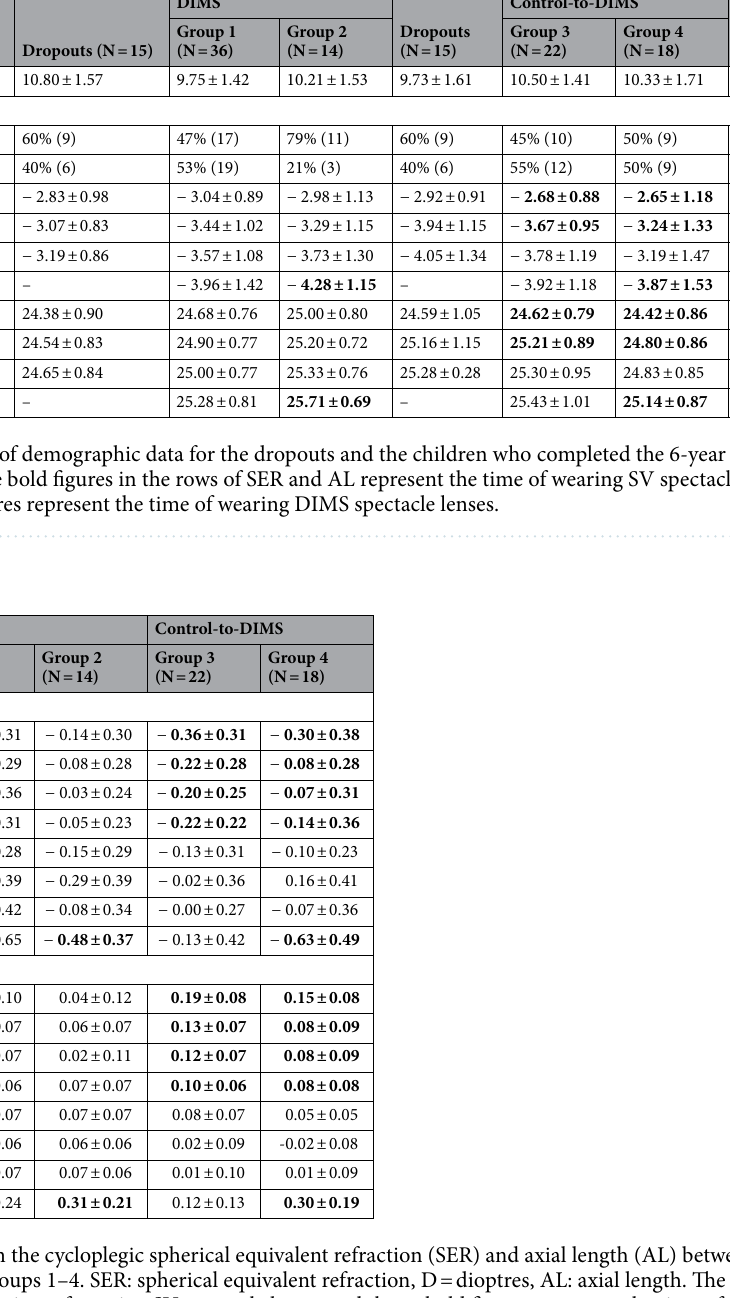
(Fig. 2), and no statistically significant difference (p > 0.05) in myopia progression was found between the first 3 years and 4 to 6 years. Myopia progression in the first 3 years was − 0.52 ± 0.66D (annual rate: − 0.17D/year) while progression between 3 and 6 years was − 0.40 ± 0.71D (− 0.13D/year). Changes in SER and AL from 3.5 to 6 years. Figure 3 shows the changes in SER and AL between 3.5 and 6 years in different groups. Group 3 showed the least myopia progression and axial elongation in the last 2.5 years among the groups. Both the DIMS lens groups (Group 1 and Group 3) had less myopia progression and axial elongation than the single vision lens groups (Group 2 and Group 4). Between the groups wearing DIMS lenses, Group 3 children showed slower myopia progression and axial elongation in the last 2.5 years than Group 1, but only the changes of AL (0.13 ± 0.46 mm, p = 0.023) showed statistically significant differences. Group 2 and